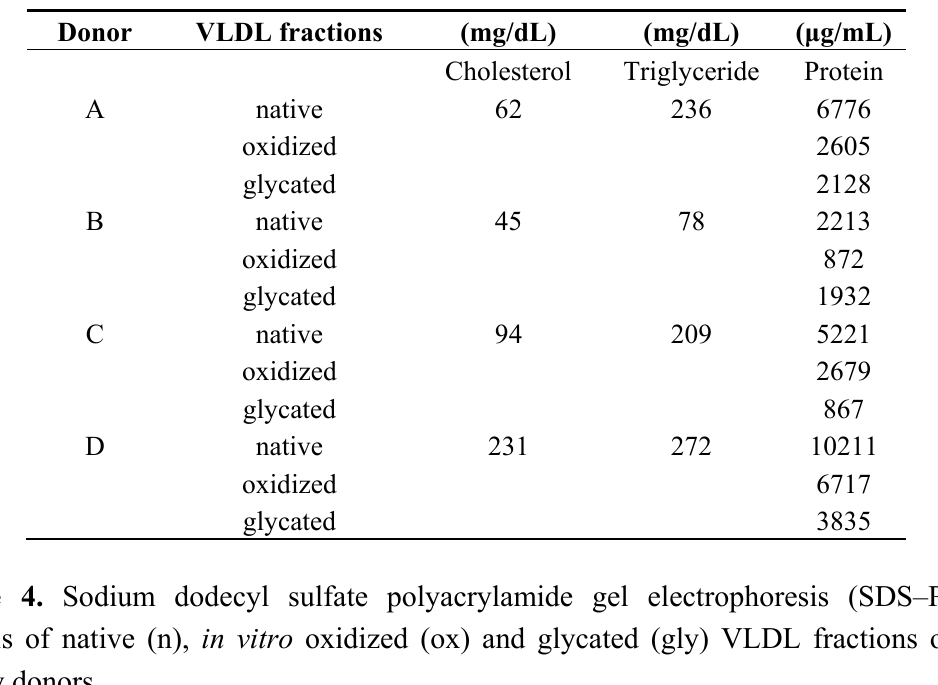
Table 4. The concentrations of cholesterol, triglyceride and protein of native, in vitro oxidized and glycated VLDL particles (data are means of three replicates).